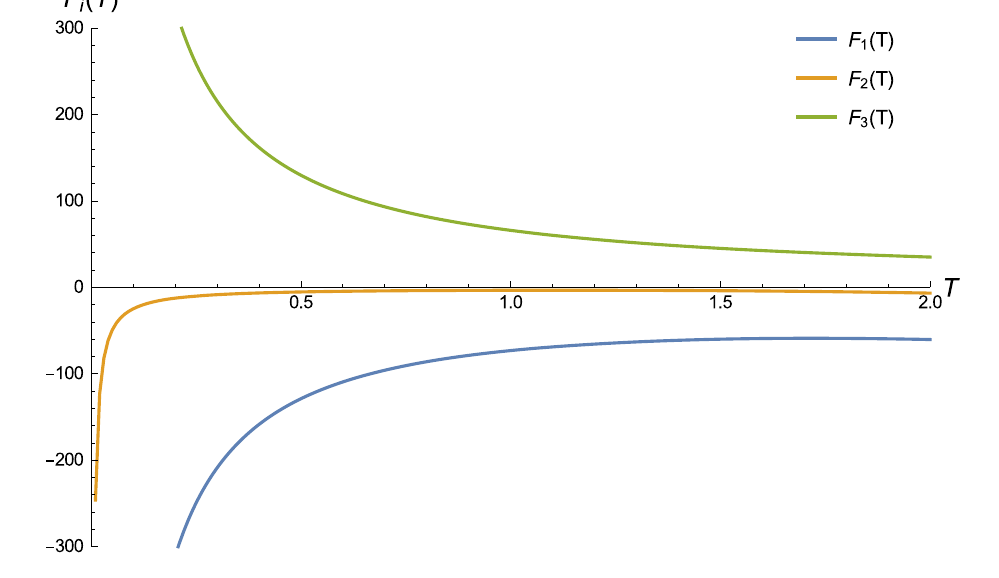
Fig. 8 The three diagrams are divergent with a simple pole in T = 0